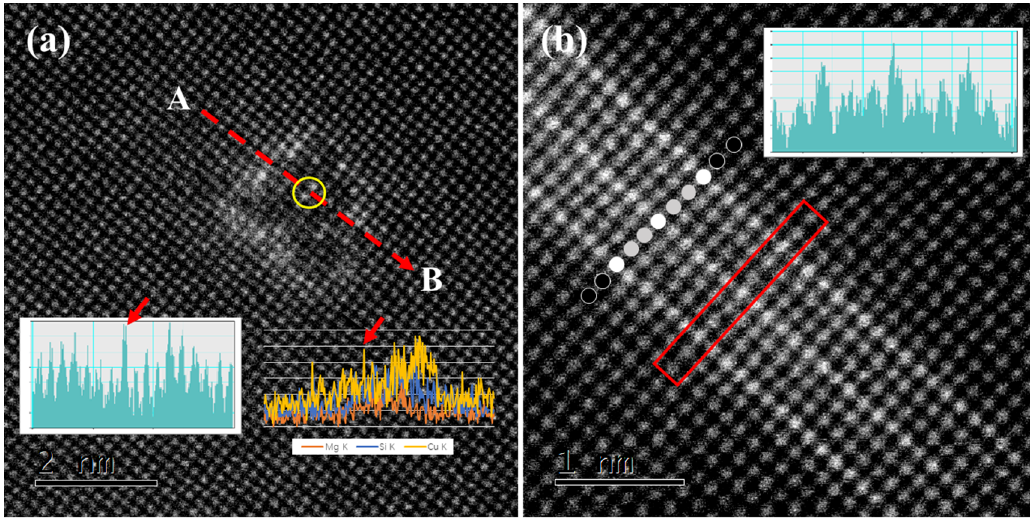
Figure 6. HAADF-STEM image of the GP zone after aging for 2 h, [100] (cid:3002)(cid:3039) ( a ) Type I GP zone and the inserted EDS line scan results; ( b ) Type II GP zone. inserted EDS line scan results; ( b ) Type II GP